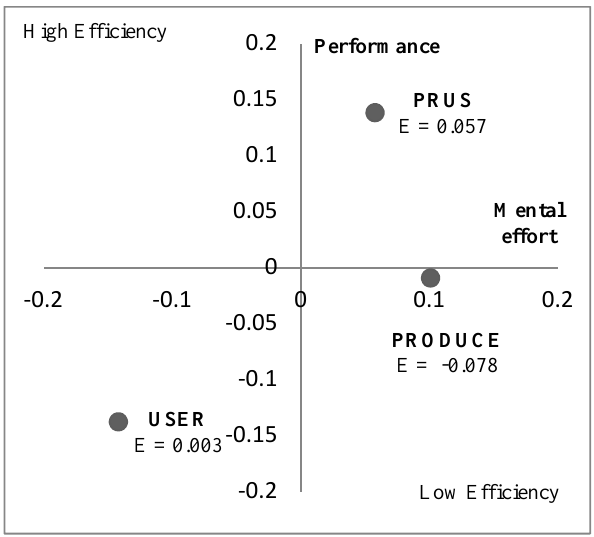
Figure 7. Representation of relative condition efficiency (E) for producing screencast (PRODUCE), produce and user of screencast (PRUS) and user of screencast (USER) for easy